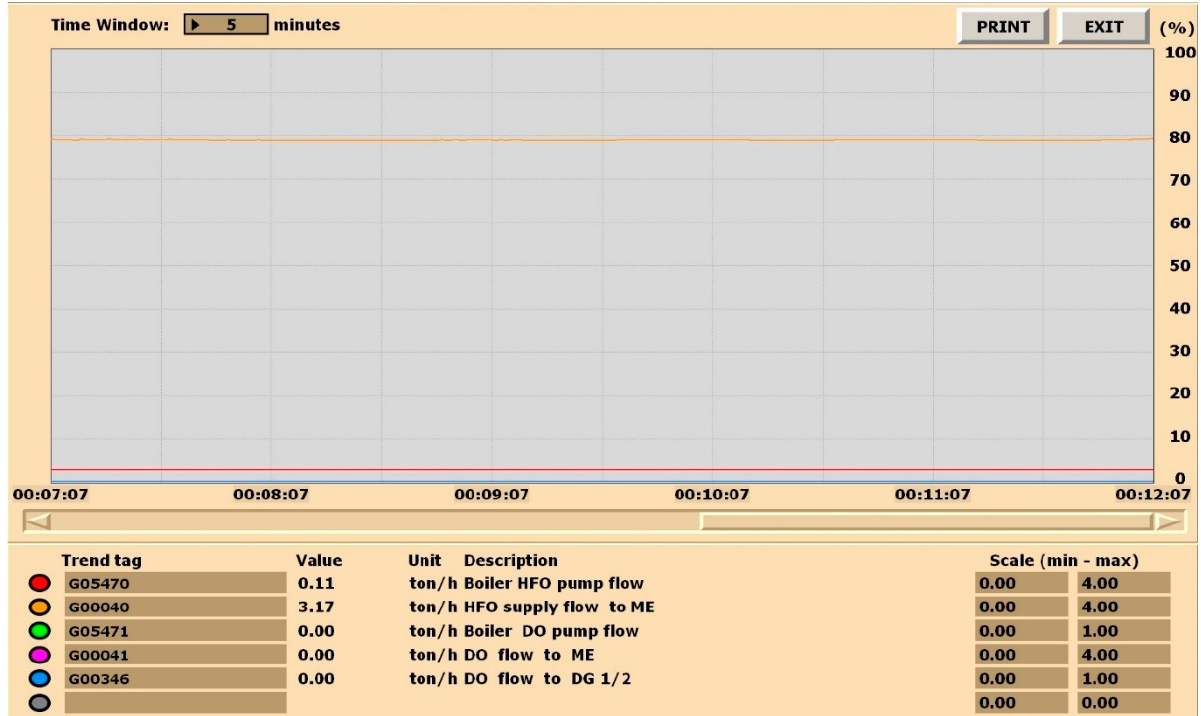
Figure 1. Fuel flows for mode 1.1.